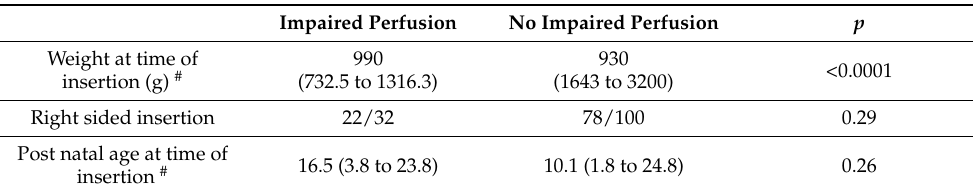
Table 4. Weight at time of insertion, post natal age and side of insertion in babies with and without impaired perfusion following FAC insertion.